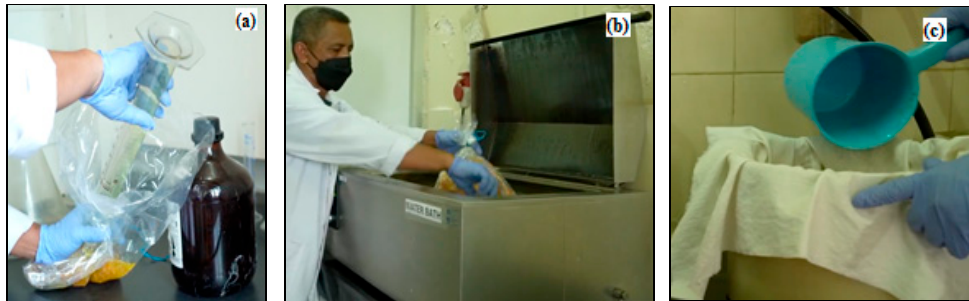
Figure 6. ( a ). The initial chlorine dioxide addition process is 0.22 KN (kappa number); ( b ). Heating with a time of 30 min and a temperature of 95 °C; ( c ). EFB fiber was cooked at 130 °C for 60 min (time to reach maximum temperature was 60 min and held for 90 min).